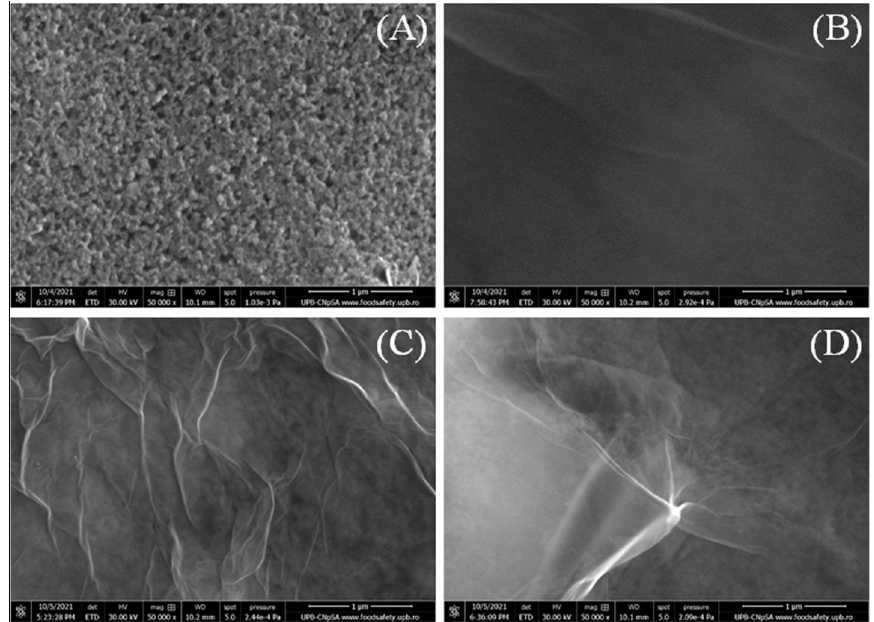
Figure 1. SEM images of bare SPCE ( A ), GO/SPCE ( B ), RGO/SCPE ( C ), and Ar-COOH/RGO/SPCE ( D ). Images recorded at 50 kX magnification. ( D ). Images recorded at 50 kX